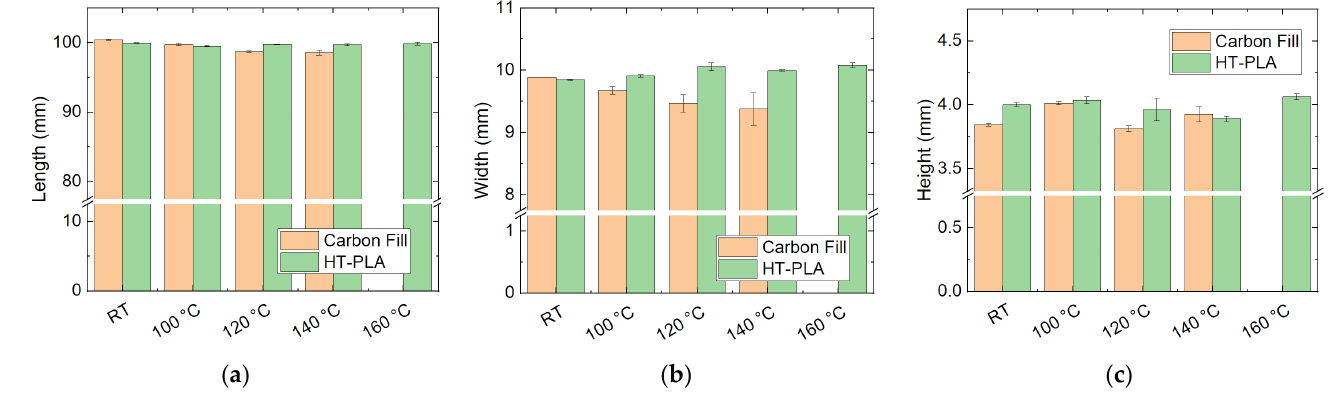
Figure 10. Dimensions of other filled samples, as printed (RT) and heat-treated at different temperatures: ( a ) length; ( b ) width; ( c ) height.